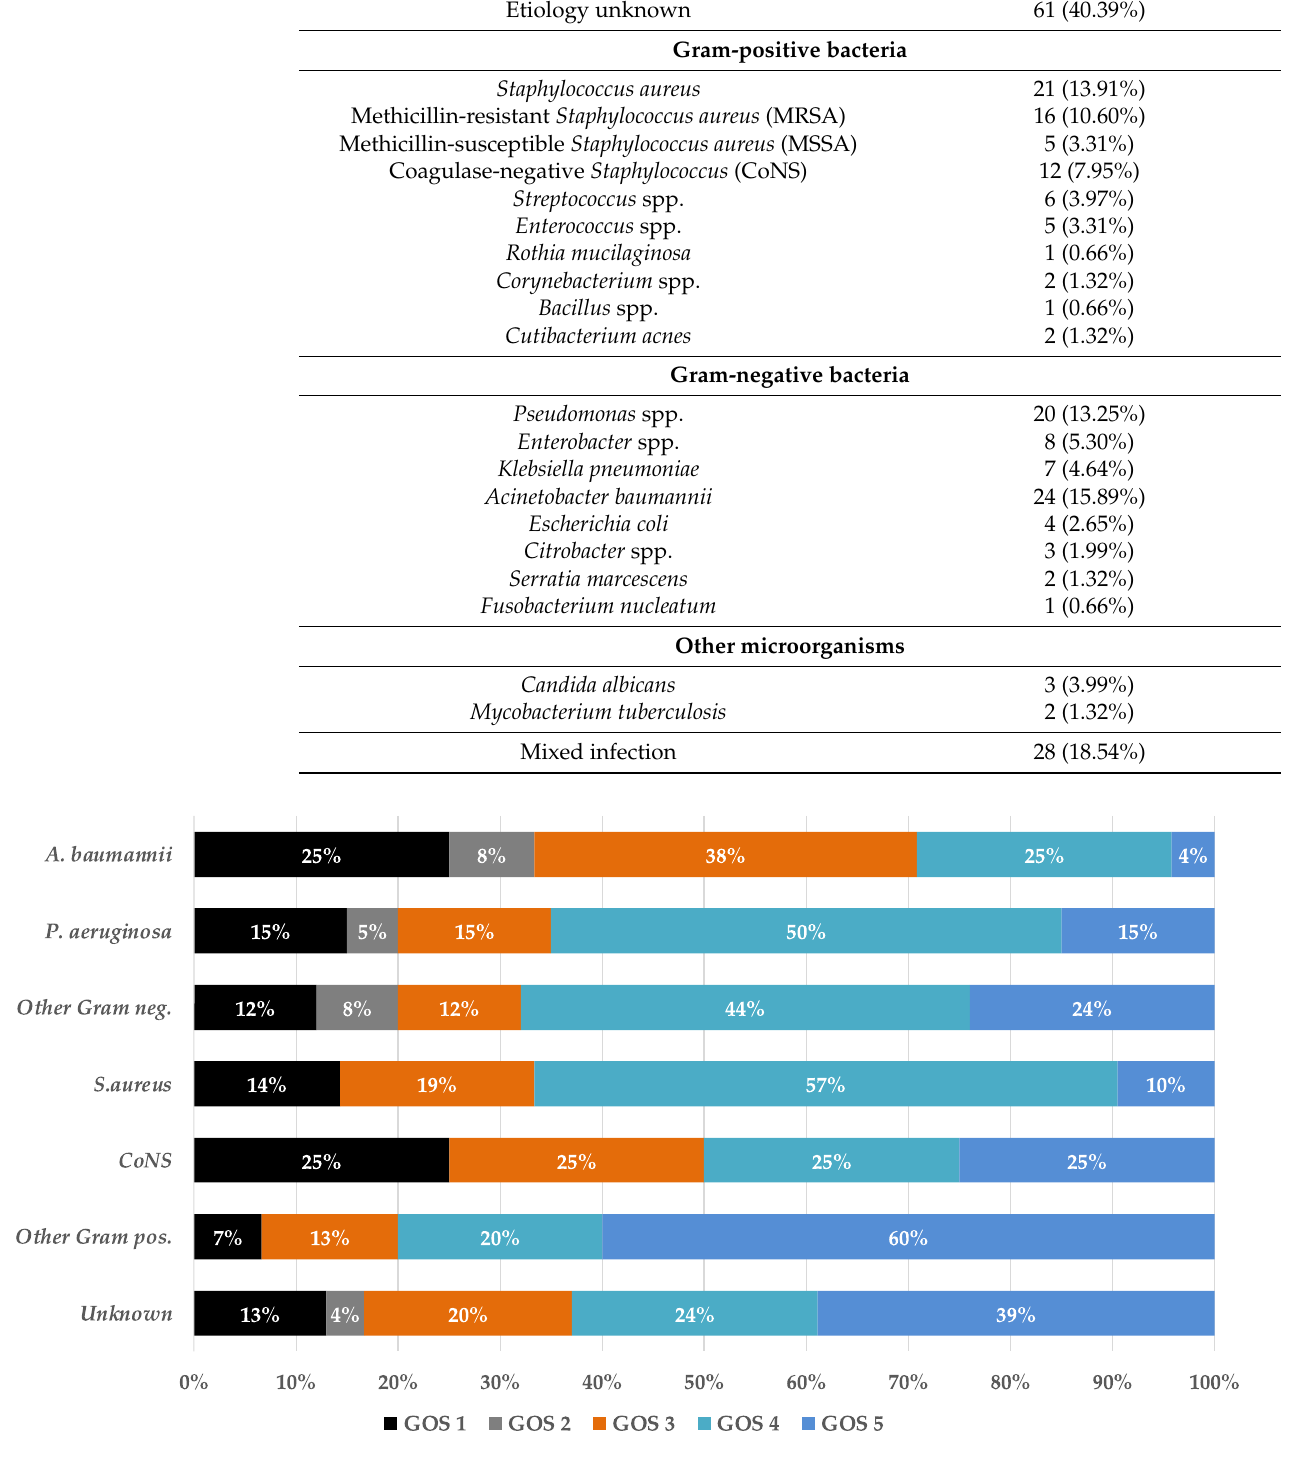
Figure 1. The stratified clinical outcomes by etiology expressed as Glasgow outcome score (GOS).